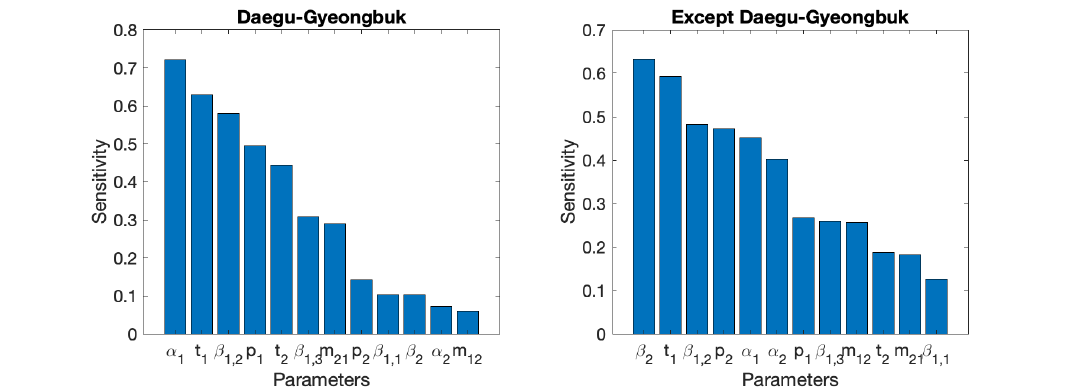
Figure 6. A global sensitivity analysis is displayed; left panel of patch 1 and right panel of patch 2 under various patch-specific